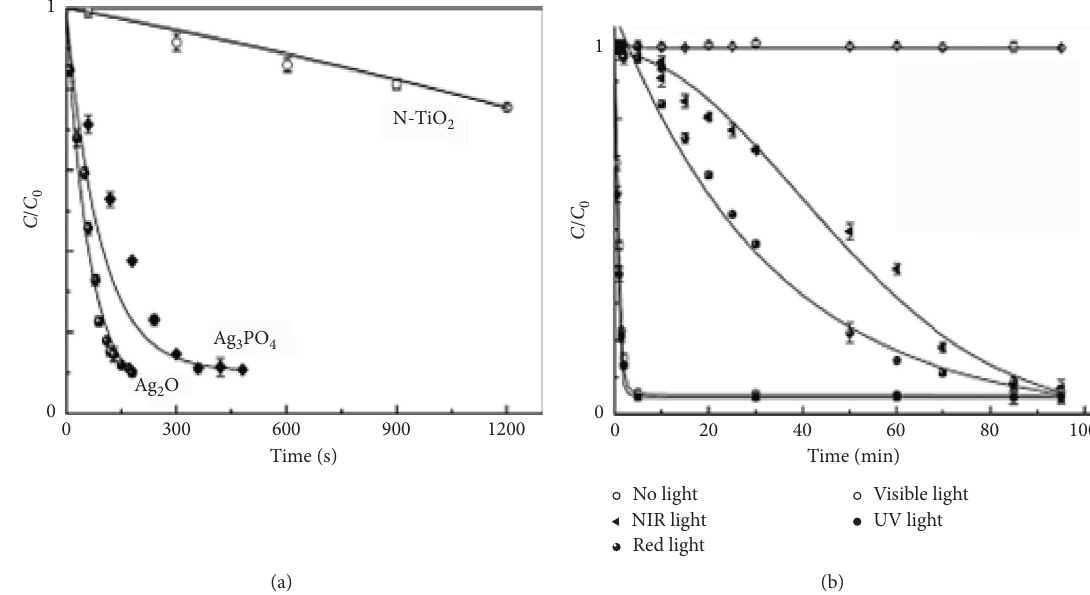
Figure 9: (a) Photocatalytic activity of Ag 2 O, Ag 3 PO 4 , and NTiO 2 . (b) The effect of light source on photocatalytic activity of Ag 2 O NPs [7].